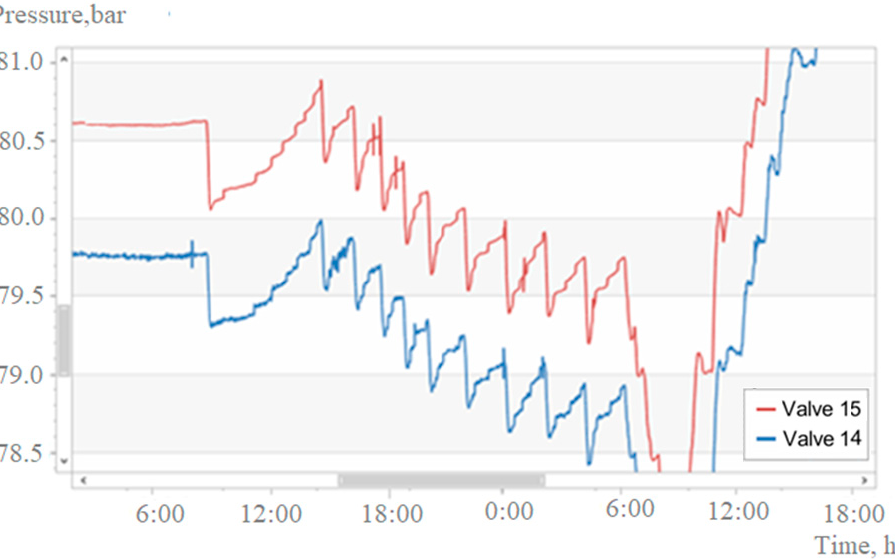
Figure 8. Wave processes recorded by two pressure gauges located 13 km apart. “Standing” waves. Example 6.